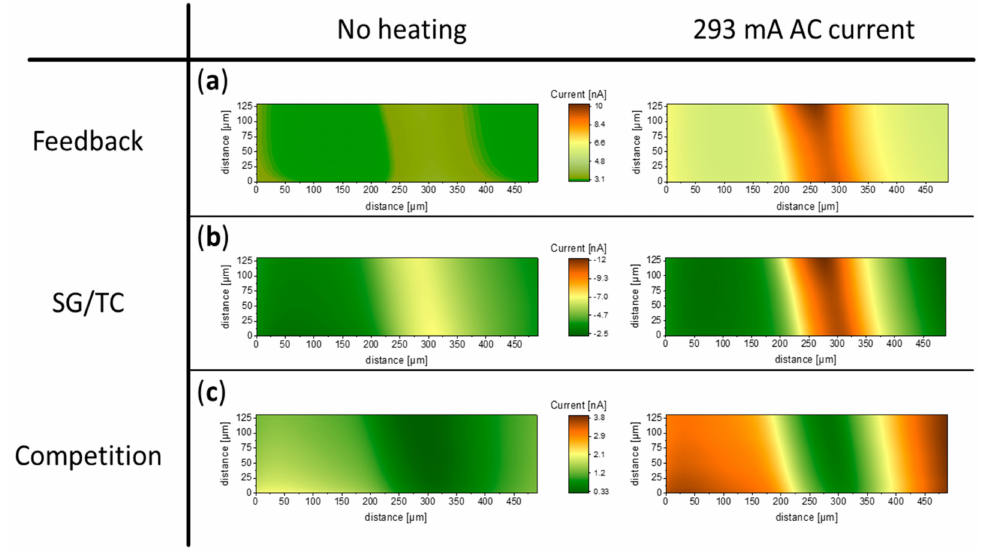
Figure 4. Images of a flattened Pt wire (width = 70 µ m) recorded in di ff erent SECM measuring modes, with a 25 µ m probe without heating (left side) and with heating (right side). ( a ) Images recorded in feedback mode; ( b ) and ( c ) were obtained in SG / TC and competition mode, respectively. E (Probe)